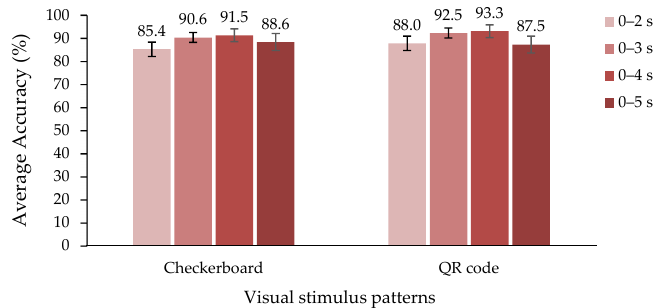
Figure 9. SSVEP stimulus duration of the checkerboard and QR code patterns, using PSD and CCA classification confidence interval (alpha: 0.01).